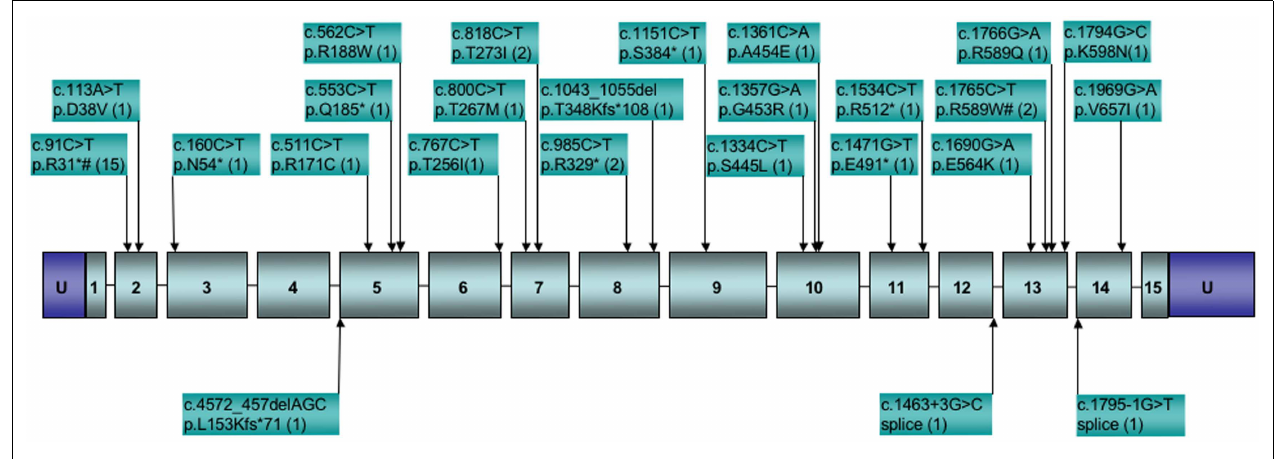
at the cDNA and protein level, followed by the number of reported cases in parentheses. *Indicates stop codon. # Mutations reported in